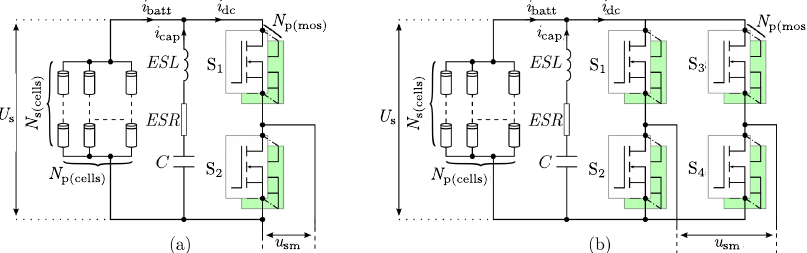
Figure 3. Schematic of battery-integrated MMC submodules. ( a ) half-bridge submodule (HB-SM) and ( b ) full-bridge submodule (FB–SM)